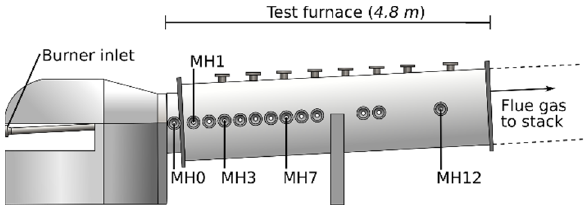
Figure 4. Schematic of the pilot-scale test furnace. Measurement ports (MH 0–12) are located along the axis of the furnace, allowing in-flame measurements, and the burner is located to the left.